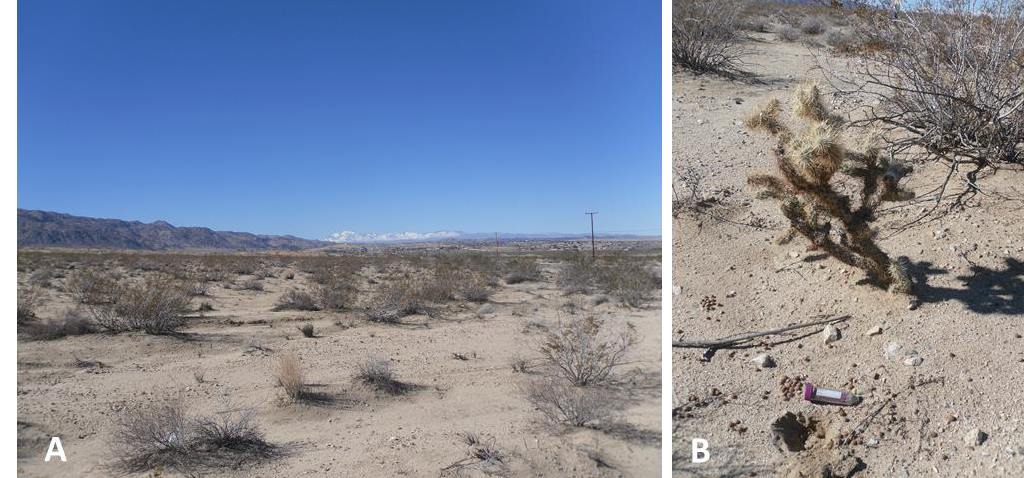
Figure 14. Overview of site 8 near Twentynine Palms showing scattered vegetation of predominantly Creosote ( Larrea tridentata ) ( A ). C. posadasii DNA-positive sampling site 9-3 near a Pencil Cholla ( Cylindropuntia ramosissima ) and Creosote in the background ( B ). Note the abundant rodent pellets nearby.